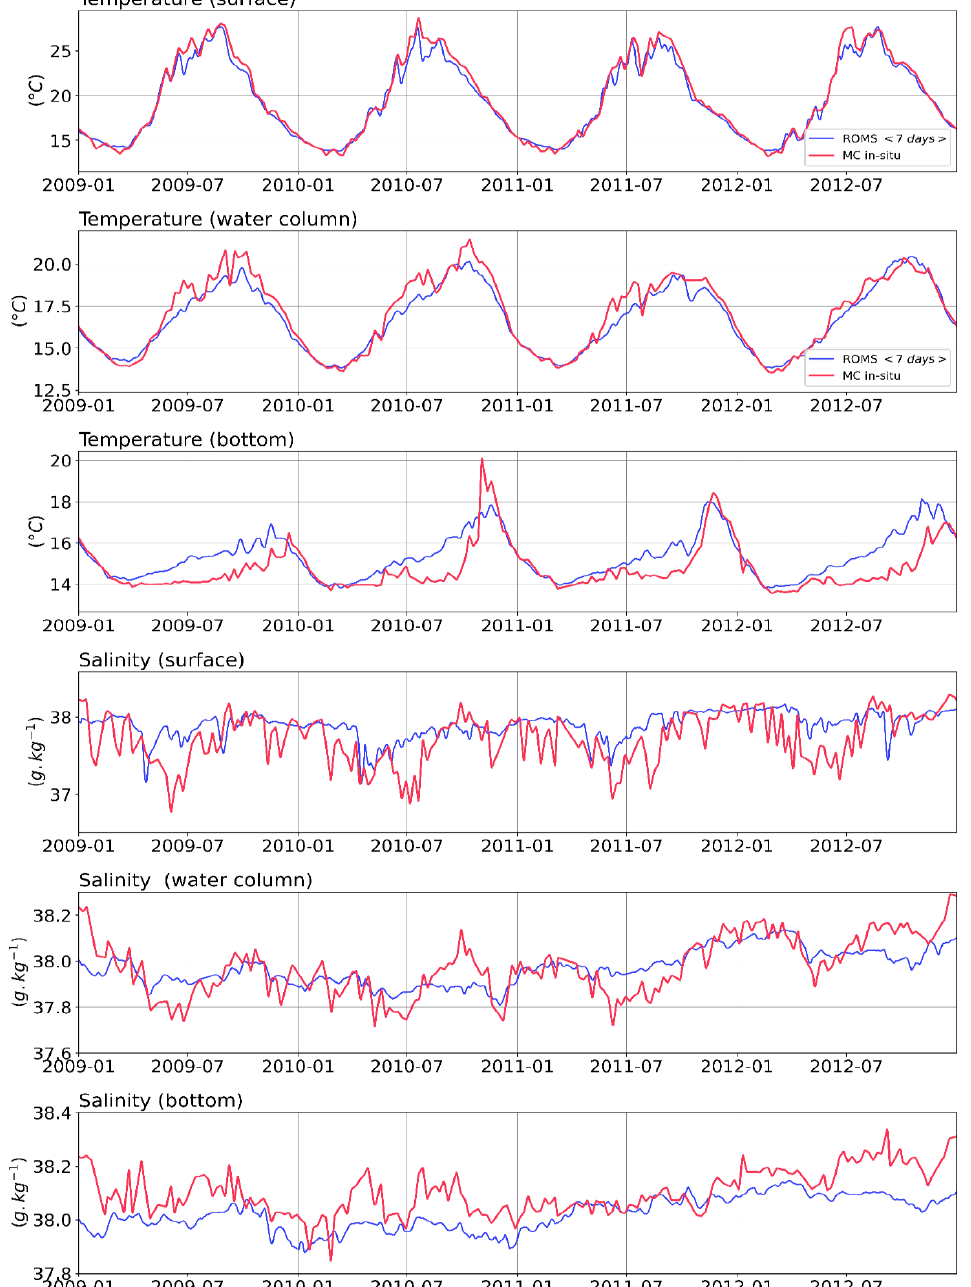
Figure 11. Time series of conservative temperature T ( ◦ C) and absolute salinity S (g · kg − 1 ) at the LTER-MC coastal station, at the surface, averaged into the water column, and at the bottom (60 m deep). Red: LTER-MC observations; blue: GNAM model.